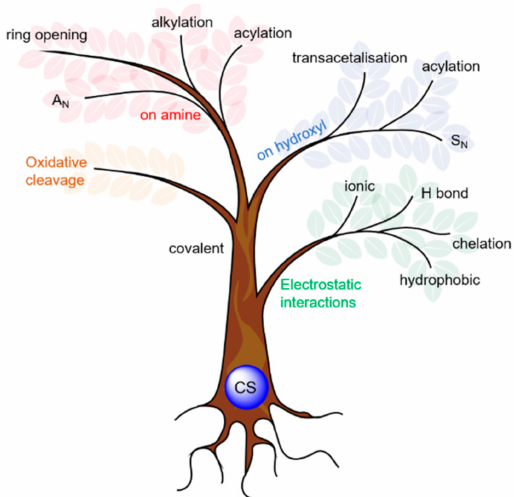
Figure 2. Overview of the different functionalization strategies of CS: electrostatic interaction ( green ), covalent functionalization on hydroxyl ( blue ) and amine ( red ), and oxidative cleavage of the back- bone ( orange ). A N : Nucleophilic addition, S N : nucleophilic